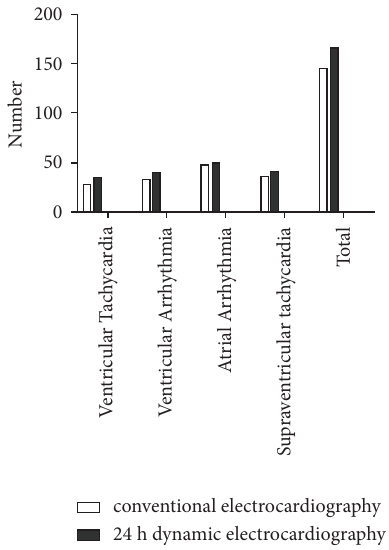
Figure 1: Comparison of detection rates of arrhythmia types between the two inspection methods ( n